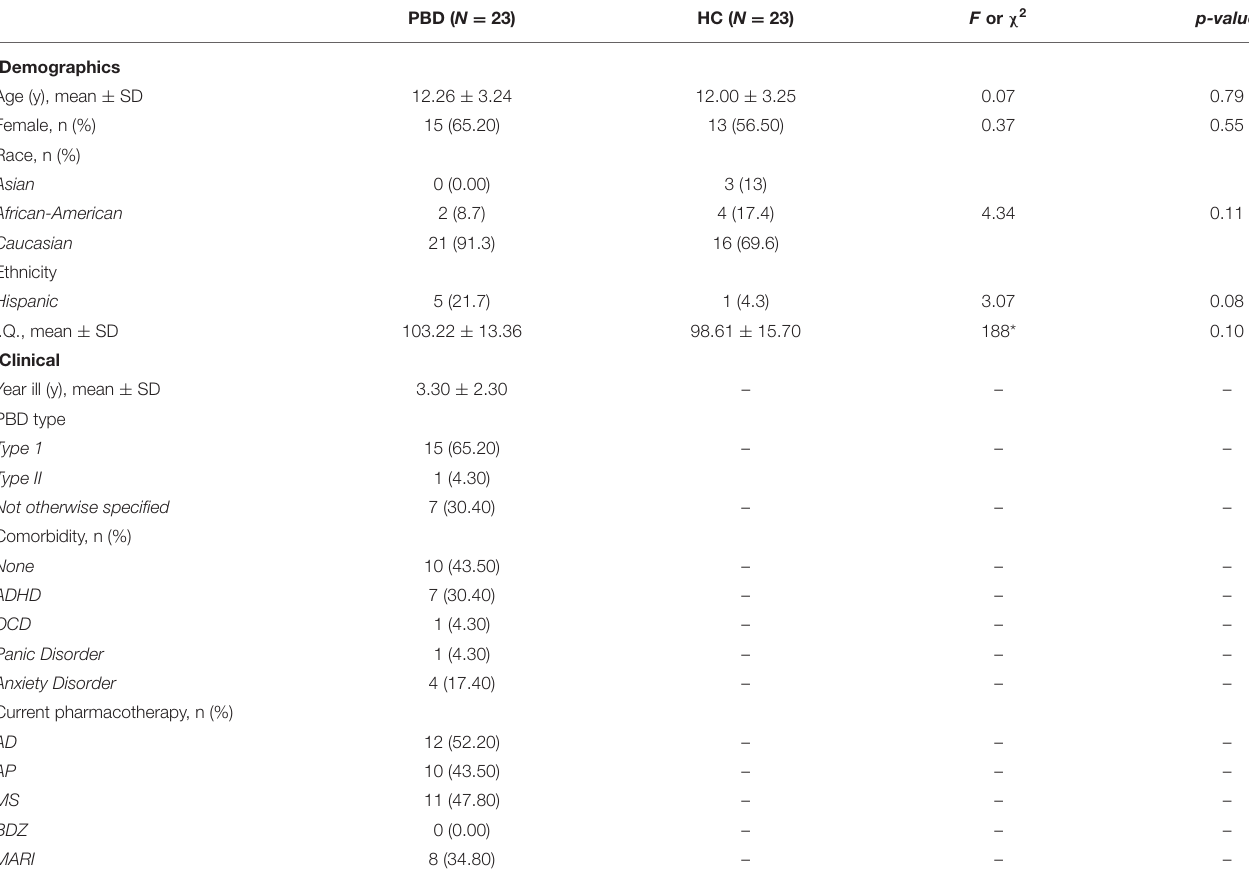
TABLE 1 | Sociodemographic and clinical characteristics of youth with PBD and HC.